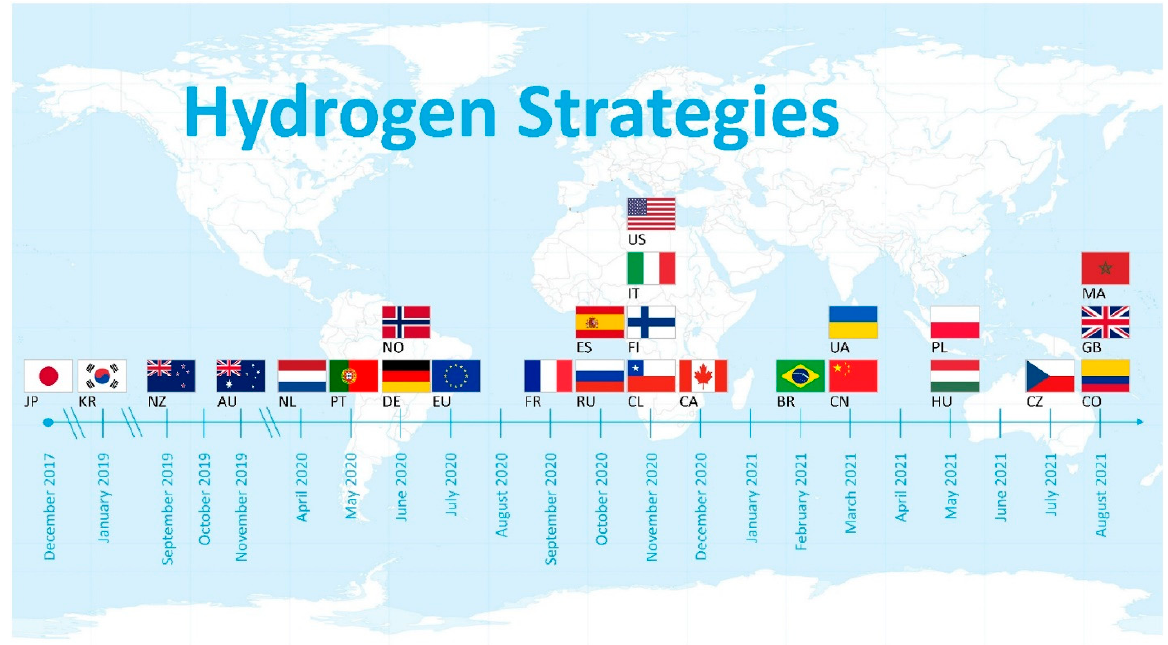
Figure 7. Summary of dates released by various countries’ roadmaps on hydrogen from December 2017 and September 2021 [64] (Published under open access).